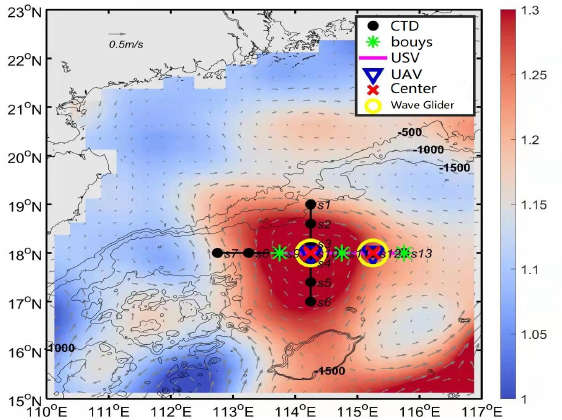
Figure 4. Finding start